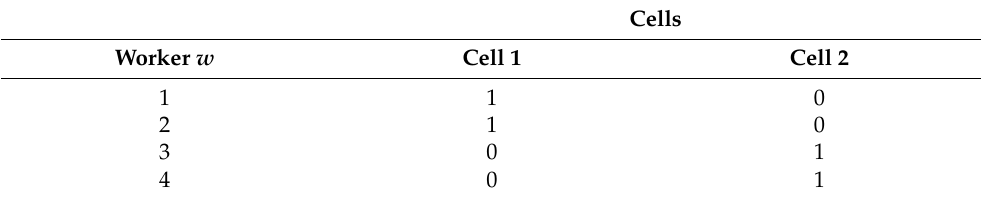
Table 8. Solution of team formation stage obtained by using two-stage ALNS for the illustrative example.